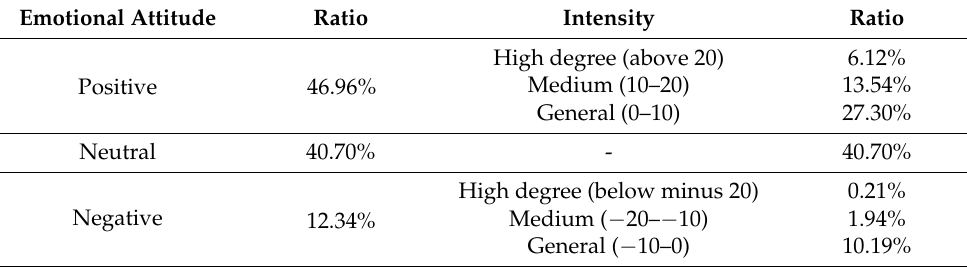
Table 4. Sentiment analysis results of the rural landscape